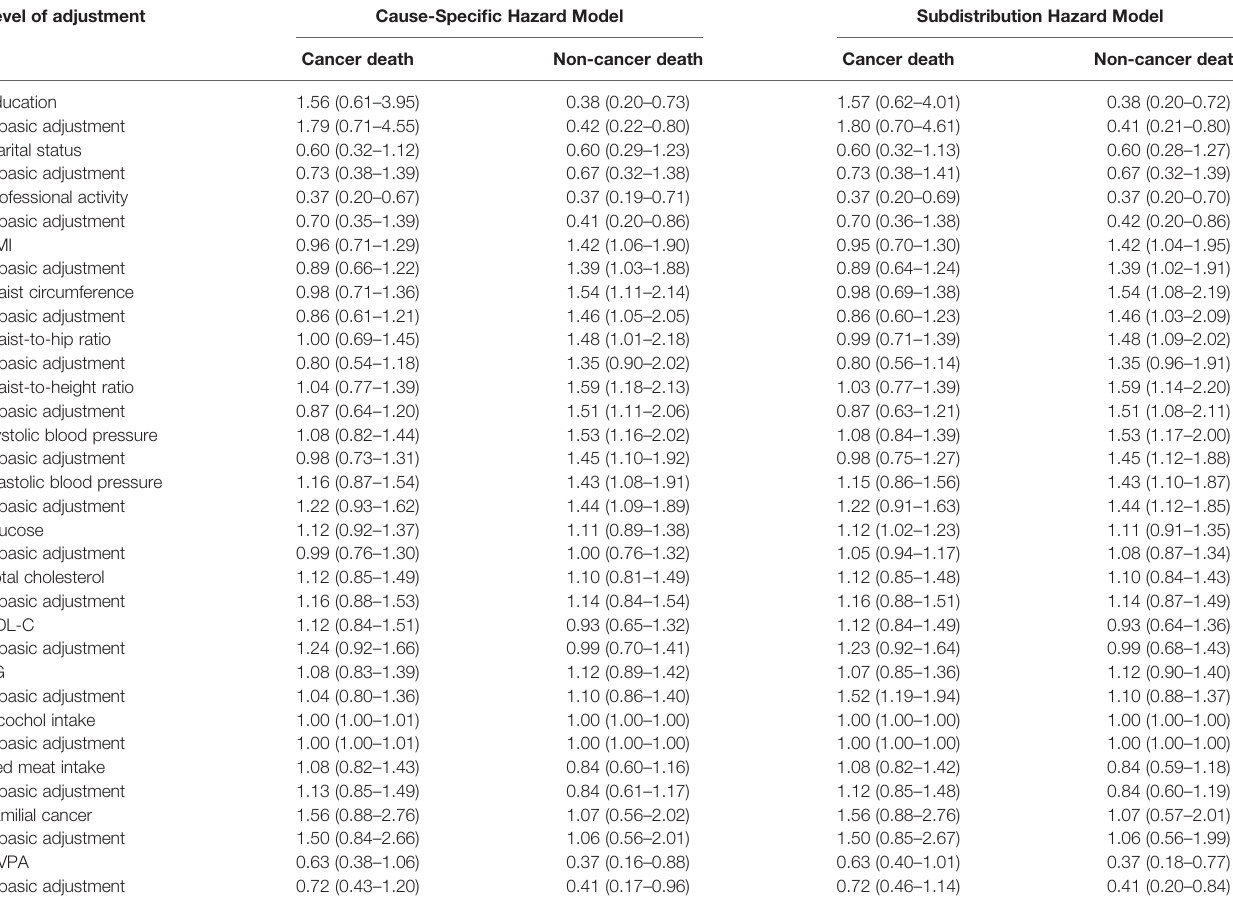
TABLE 2 | Hazard ratios with 95% con fi dence interval for cancer and non-cancer deaths, without and with adjustment for baseline levels of potential confounders and mediators. Level of